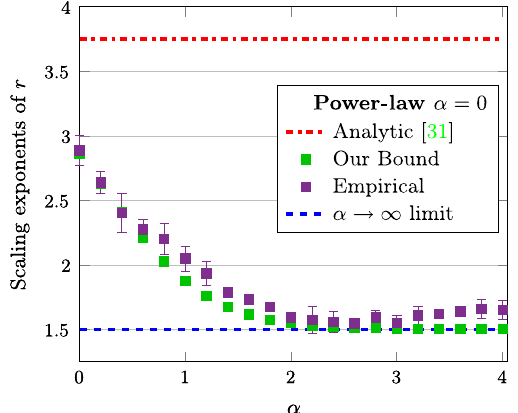
FIG. 5. Comparison of the empirical scaling exponents of the Trotter numbers (purple squares) against our bound (green squares) as functions of the system size at different values of the power-law exponent α . The error bars of the empirical values represent the standard deviation of the fitted exponents (see Fig. 4) over five instances of the random field h . The bound is j derived from the counting argument in Eq. (53) and therefore has no standard deviation. We attribute the systematic difference between our bound and the empirical values to the fact that we only compute the empirical Trotter numbers up to n ¼ 11 , which may not capture the precise asymptotic scaling in the large- n limit. We also include the scaling exponent of the analytic bound in Ref. [31] (red dash-dotted line) as well as the theoretical exponent in the limit α → ∞ , i.e., nearest-neighbor interactions (blue dashed line), for